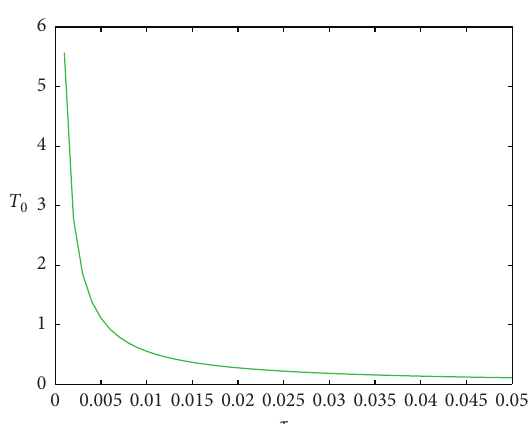
Figure 9: T 0 versus τ in the case where β μ � 1, and C W � 1.